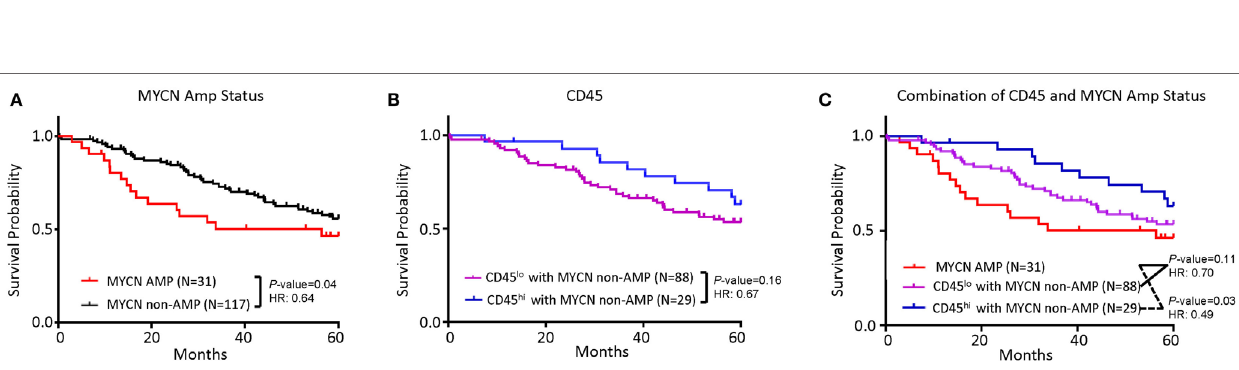
FigUre 2 | Tumor inflammation, combined with MYCN amplification is associated with neuroblastoma (NB) prognosis. (a) Kaplan–Meier curves showing 5-year survival of NB patients associated with MYCN amplification status. (b) Kaplan–Meier curves showing 5-year survival of NB patients assessed by CD45 expression. CD45 lo and CD45 hi subgroups were defined based on FPKM distribution as detailed in Section “Materials and Methods.” (c) Kaplan–Meier curves showing 5-year survival of NB patients according to the combination of MYCN amplification status and CD45 expression subtypes. The hazard ratio and P -value in (a,b,c) displayed on the graphs are from the log-rank test and Gehan–Breslow–Wilcoxon method.